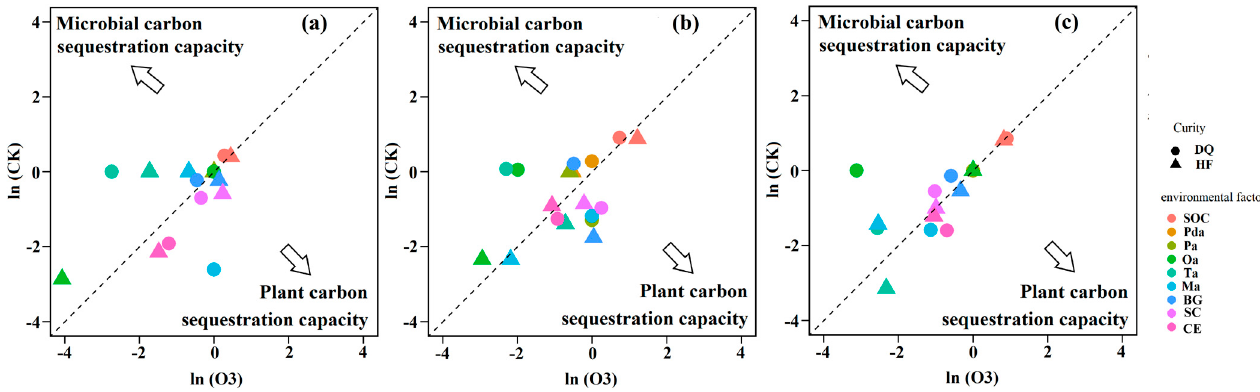
Figure 6. The ratio of CK treatment and O3 treatment using ln function in seedling ( a ), flower ( b ), and maturity ( c ) stages. Different colors represent different indicators, and triangles and circles represent HF (low soil nutrient-sensitive variety) and DQ (low soil nutrient tolerant variety), respectively. SOC, soil organic carbon; SWC, soil water content; Pda, malonic acid; Pa, propionic acid; Oa, oxalic acid; Ta, tartaric acid; Ma, malic acid; BG, β− glucosidase; SC, sucrase enzyme; CE, celluase enzyme.